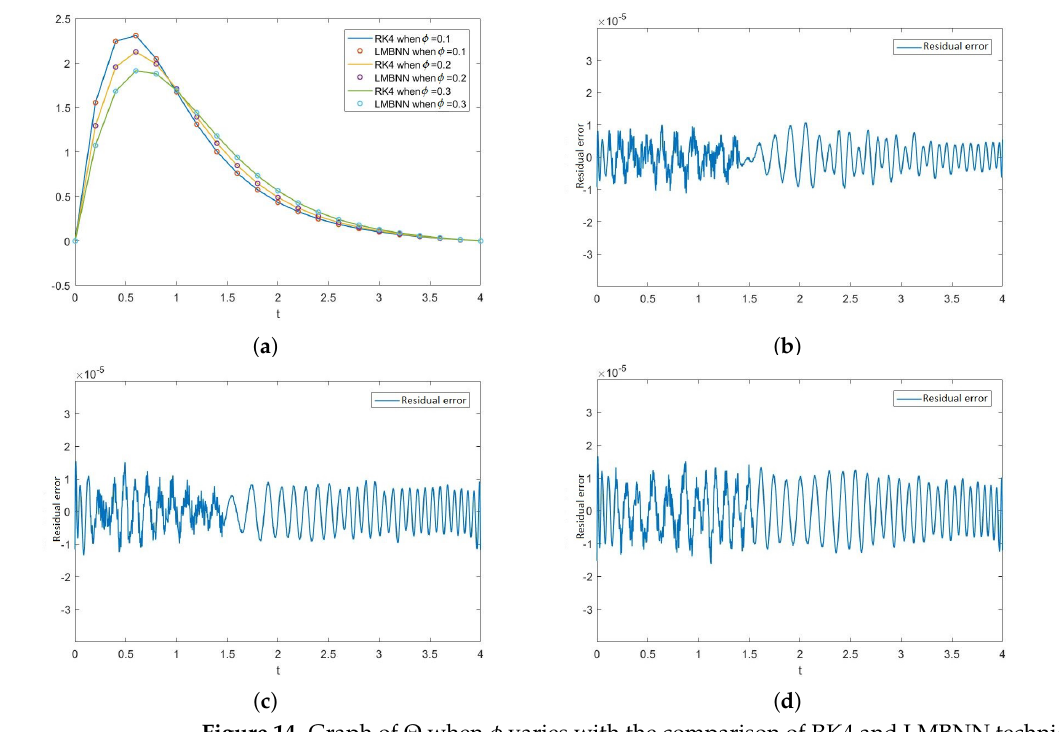
Figure 14. Graph of Θ when φ varies with the comparison of RK4 and LMBNN techniques and the graphs of the residual error between both the techniques. ( a ) Graphs of outputs of Θ obtained from RK4 and LMBNN technique when φ varies. ( b ) Error in Θ when φ = 0.1. ( c ) Error in Θ when φ = 0.2. ( d ) Error in Θ when φ = 0.3.